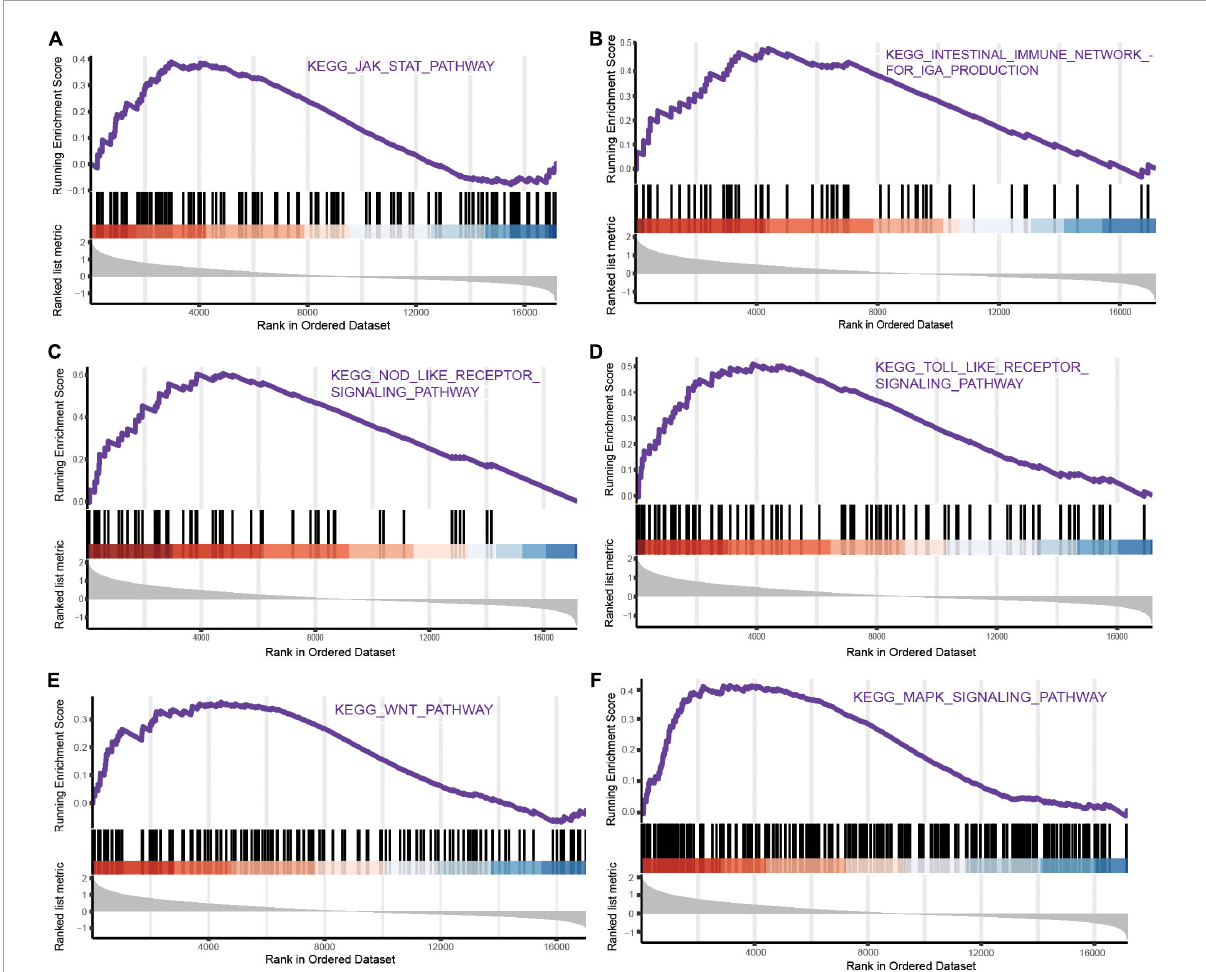
FIGURE4 The representative pathways with significant differences of mRNAs in ICH based on GSEA. (A) JAK-STAT signaling pathway. (B) Intestinal immune network pathway. (C) NOD-like receptor signaling pathway. (D) Toll-like receptor signaling pathway. (E) Wnt signaling pathway. (F) MAPK signaling